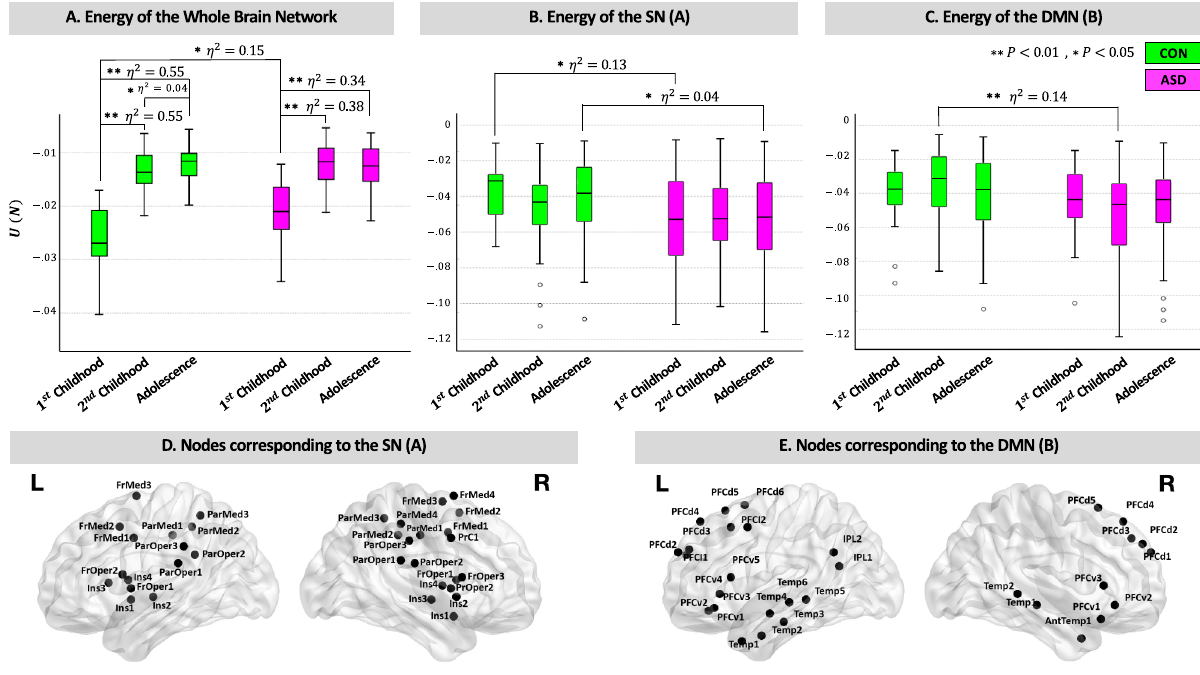
Figure 3. Energy of the brain (sub) networks during development. ( A ) For both groups, energy of the whole brain network increases monotonically with age, yet ANCOVA results show that the pattern of this increase is different between the two groups. ( B , C ) The effect of age on energy of the SN ( A ) and DMN ( B ) is significant, with ASD having less energies in both sub-networks. Results of Mann-Whitney U tests with corresponding 2 effect sizes ( η ) are shown above each of the box plots. ( D , E ) Regions of interest related to the SN ( A ) and DMN ( B ), as has been defined in the Schaefer atlas. BrainNet Viewer 1.63 40 (https ://www.nitrc .org/proje cts/bnv) has been used for visualization of the brain networks. SN, the salience/ventral attention network; DMN, the default mode network; Ins, the insula; PFC, the prefrontal cortex; Temp, the temporal cortex; FrOper, the frontal opercular; ParOper, the parietal opercular; FrMed, the frontal medial; IPL, the inferior parietal lobule; CON, control; ASD, autism spectrum disorder (Color